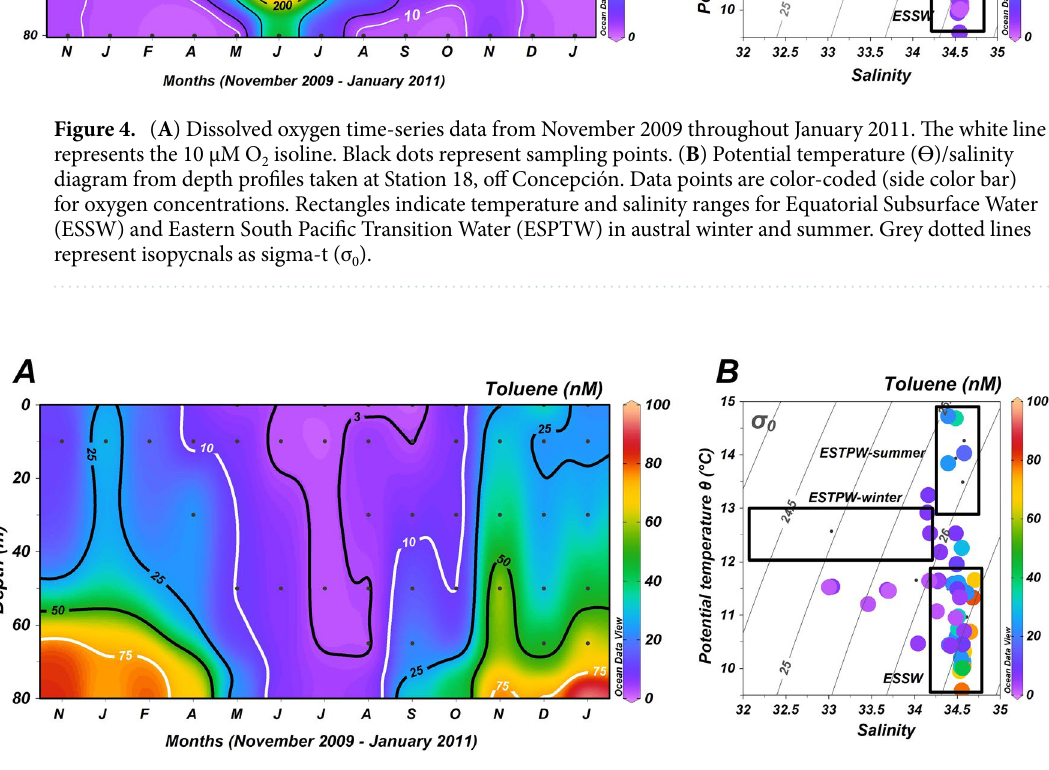
Figure 5. ( A ) Toluene time-series data from November 2009 to January 2011. White lines represent the 10 and 75 µM toluene isolines. Black dots represent sampling points. ( B ) Potential temperature ( ϴ )/salinity diagram from depth profiles taken at Station 18, off Concepción. Data points are color-coded (side color bar) for toluene concentrations. Rectangles indicate temperature and salinity ranges for Equatorial Subsurface Water (ESSW) and Eastern South Pacific Transition Water (ESPTW) in austral winter and summer. Grey dotted lines represent isopycnals as sigma-t (σ 0